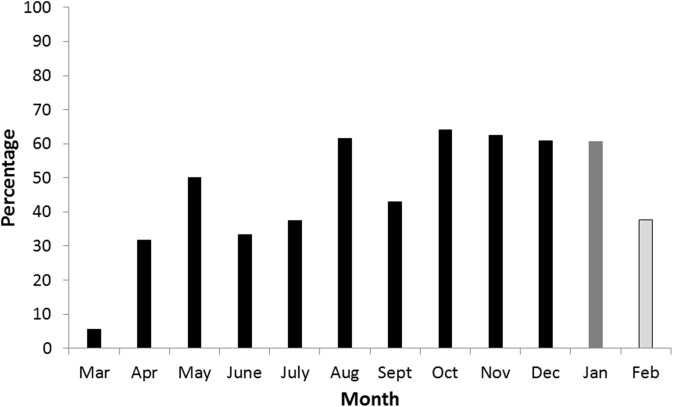
Proportion of females with blastocysts in each month.The proportion of females, by month, carrying blastocysts (back bars, March to December), foetuses (dark grey bar, January) or that were postpartum (light grey bar: February).